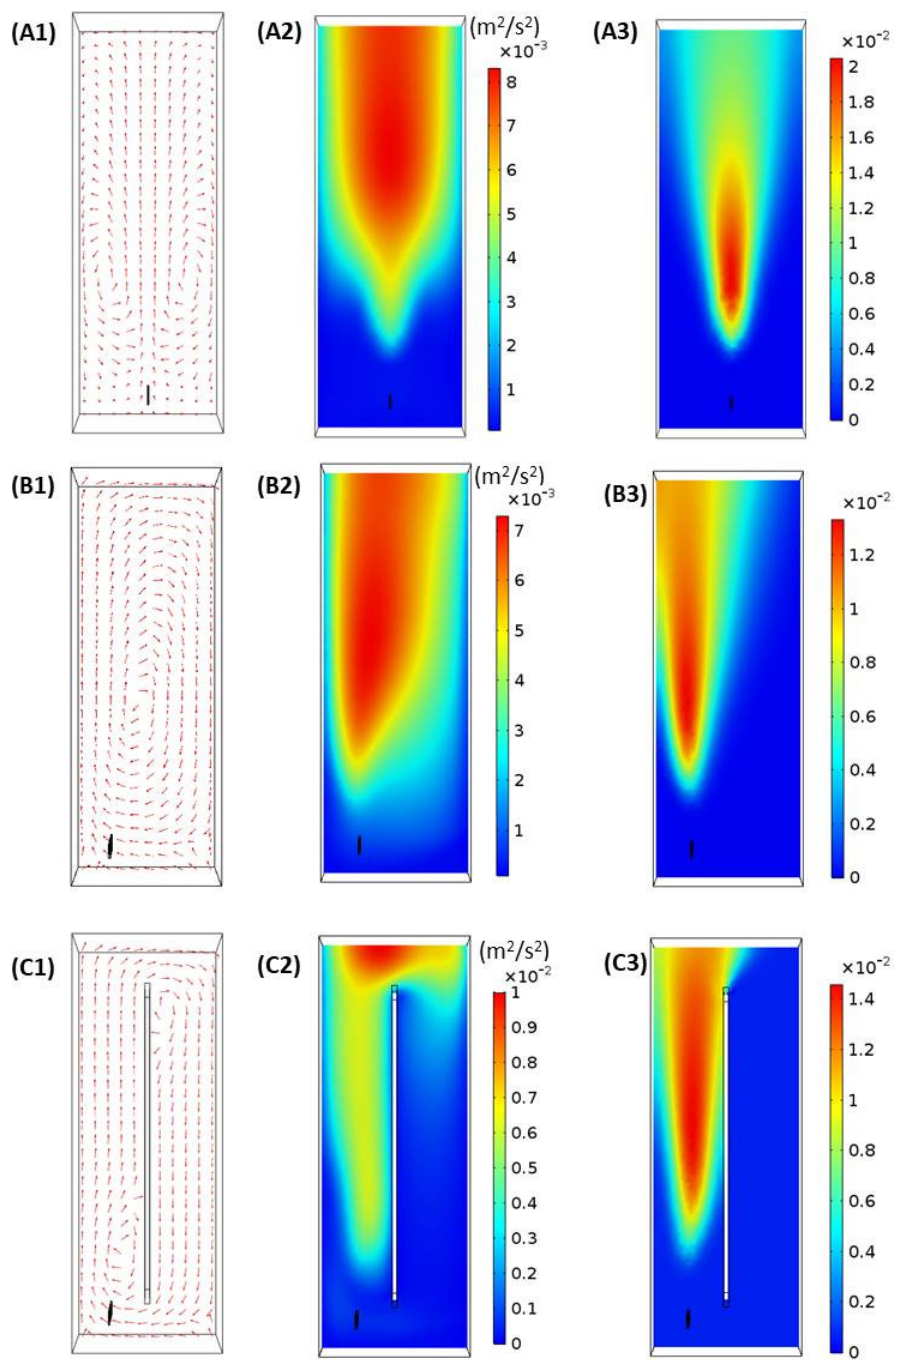
Figure 5. Hydrodynamic simulations of the three PBR designs, using an air inlet flowrate of 0.5 L/min for all cases. Comparison of results along depth and height from the ( A ) Standard Design, ( B ) Alternate Design A, and ( C ) Alternate Design B. Properties shown are (1) normalized water velocity vectors, (2) turbulent kinetic energy, and (3) air volume fraction.